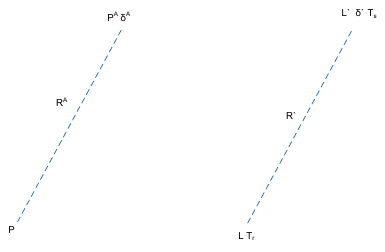
Figure 8. Perspective of attackers and